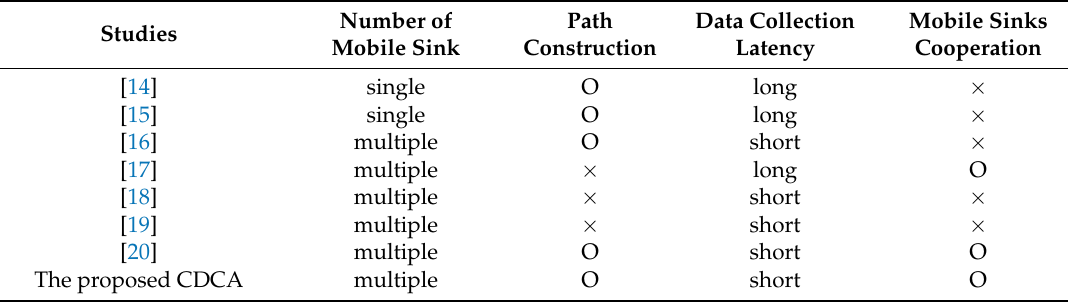
Table 1. Comparison between the proposed CDCA and existing mechanisms.